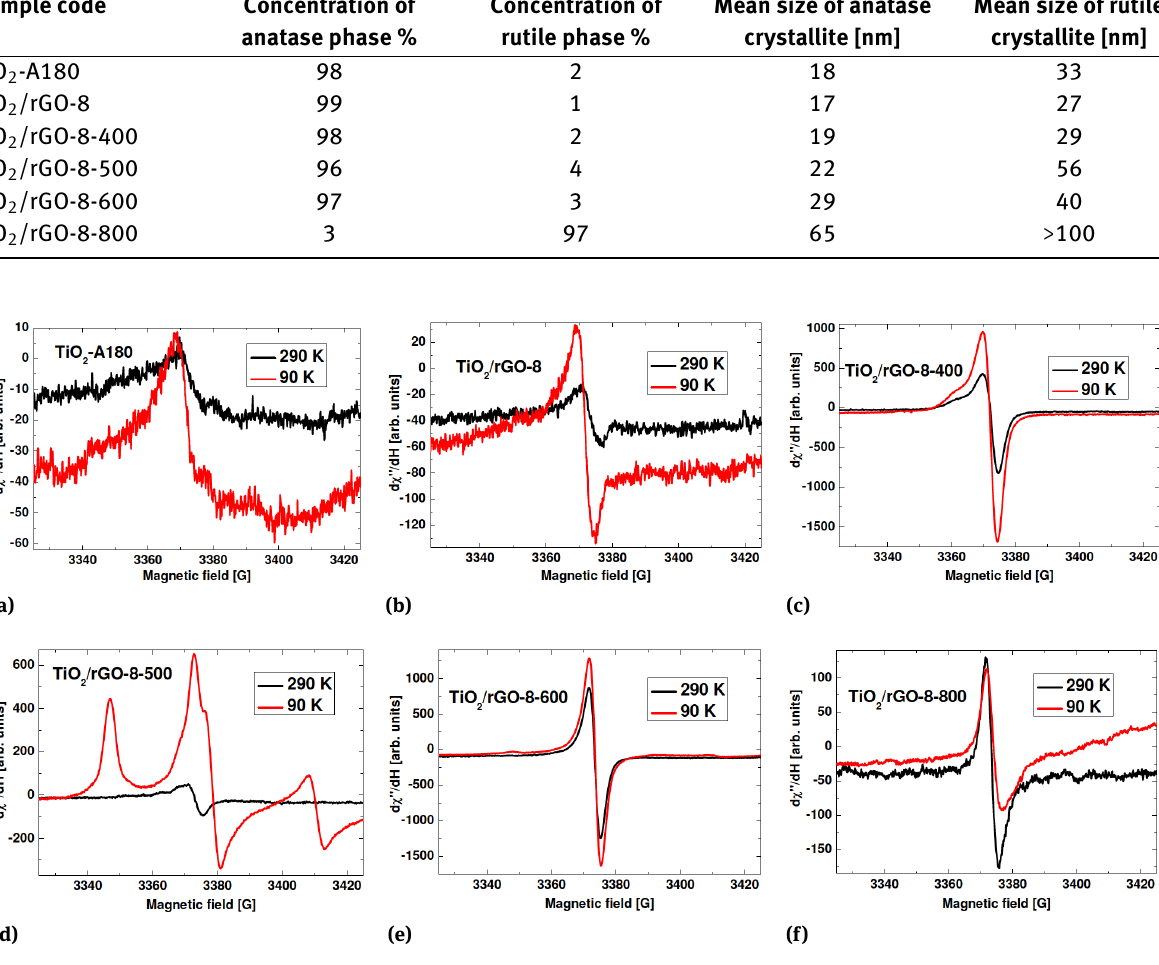
Figure 2: The EPR spectra of nanocomposites at 90 K (red) and 290 K (black): (a) TiO 2 -A180, (b) TiO 2 /rGO-8, (c) TiO 2 /rGO-8-400, (d) TiO 2 /rGO-8-500, (e) TiO 2 /rGO-8-600 and (f) TiO 2